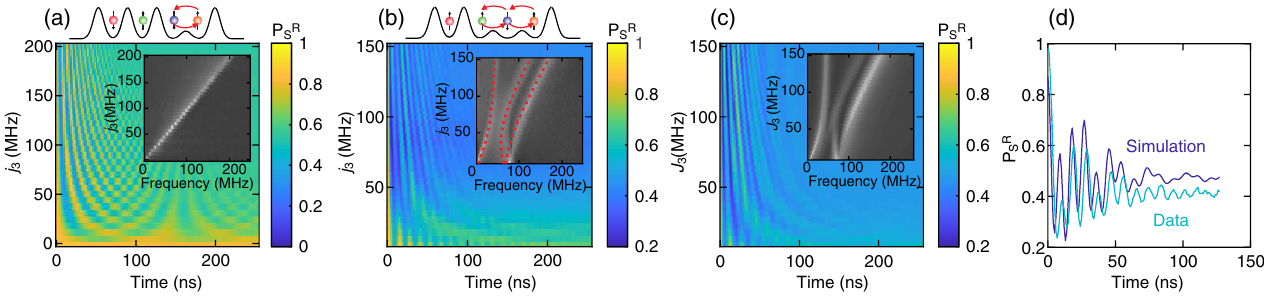
FIG. 4. Two- and three-spin exchange coupling. (a) Two-spin exchange oscillations obtained by linearly sweeping j 3 from 0 to 200 MHz. Inset: FFT of the data. (b) Three-spin exchange oscillations obtained by linearly sweeping j 3 from 10 to 150 MHz and fixing j 2 at 70 MHz. Inset: FFT of the data. Theoretical predictions of the exchange oscillation frequencies are overlaid in red. (c) Simulated three-spin exchange oscillations corresponding to the data in panel (b). Inset: Simulated FFT. (d) Line cuts from panels ð L Þ (b) and (c) at j 2 ¼ j 3 ¼ 70 MHz. In all panels, P R is the singlet return probability of the right (left) pair of S